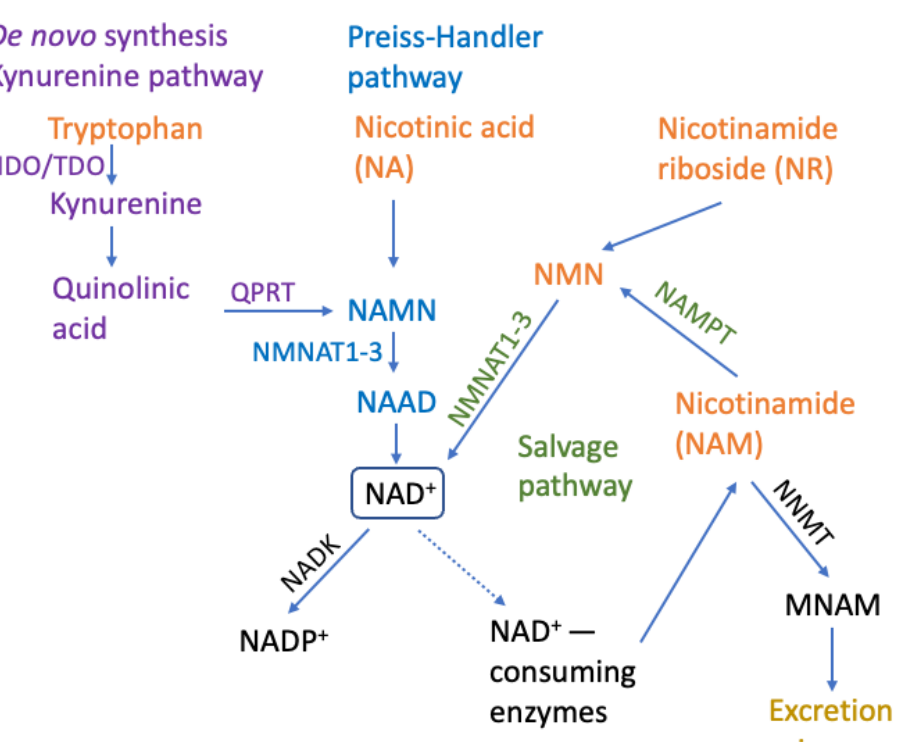
Figure 1. NAD+ metabolism. The two biosynthetic pathways, Kynurenine/De novo synthesis and Preiss–Handler pathway, with crucial steps and enzymes are indicated in violet and blue, respectively, and the salvage pathway is in green. The common NAD+ precursors available from diet are in orange. NAD+ consumption and degradation pathways and enzymes are in black. NAD+-consuming enzymes are PARP1-17, SIRT1-7 and glycohydrases/NADases: CD38, CD157 and SARM1. IDO: indoleamine 2,3-dioxygenase; TDO: tryptophan 2,3-dioxygenase; QPRT: quinolinate phosphoribosyltransferase; NAMN: nicotinamide mononucleotide; NMNAT1-3: nicotinamide mononucleotide adenylyltransferases; NAAD: nicotinic acid adenine dinucleotide; NAD+: nicotinamide adenine dinucleotide; NADK: NAD+ kinase; NADP+: nicotinamide adenine dinucleotide phosphate; NNMT: nicotinamide N-methyltransferase; MNAM: N 1 -methylnicotinamide; NAMPT: nicotinamide phosphoribosyltransferase; NMN: nicotinamide mononucleotide.